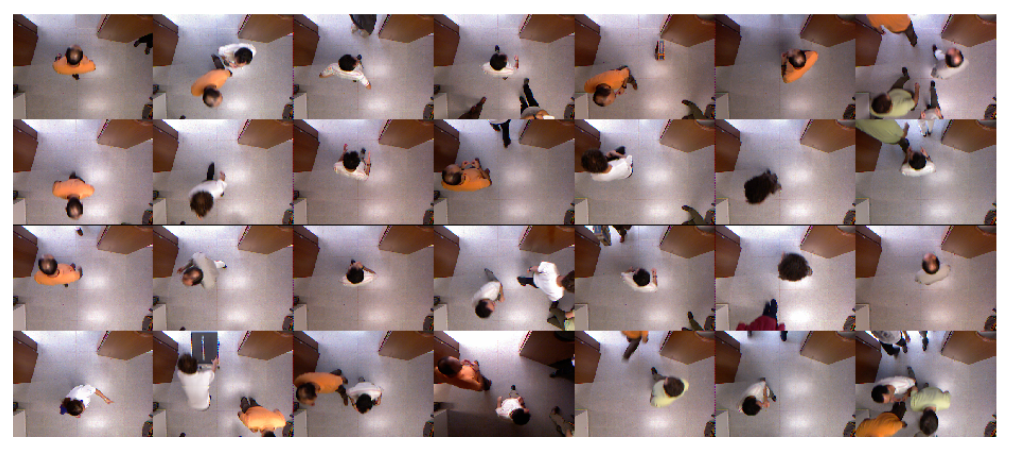
Figure 7. Examples of central frames of some trajectories detected as valid from SequenceA.